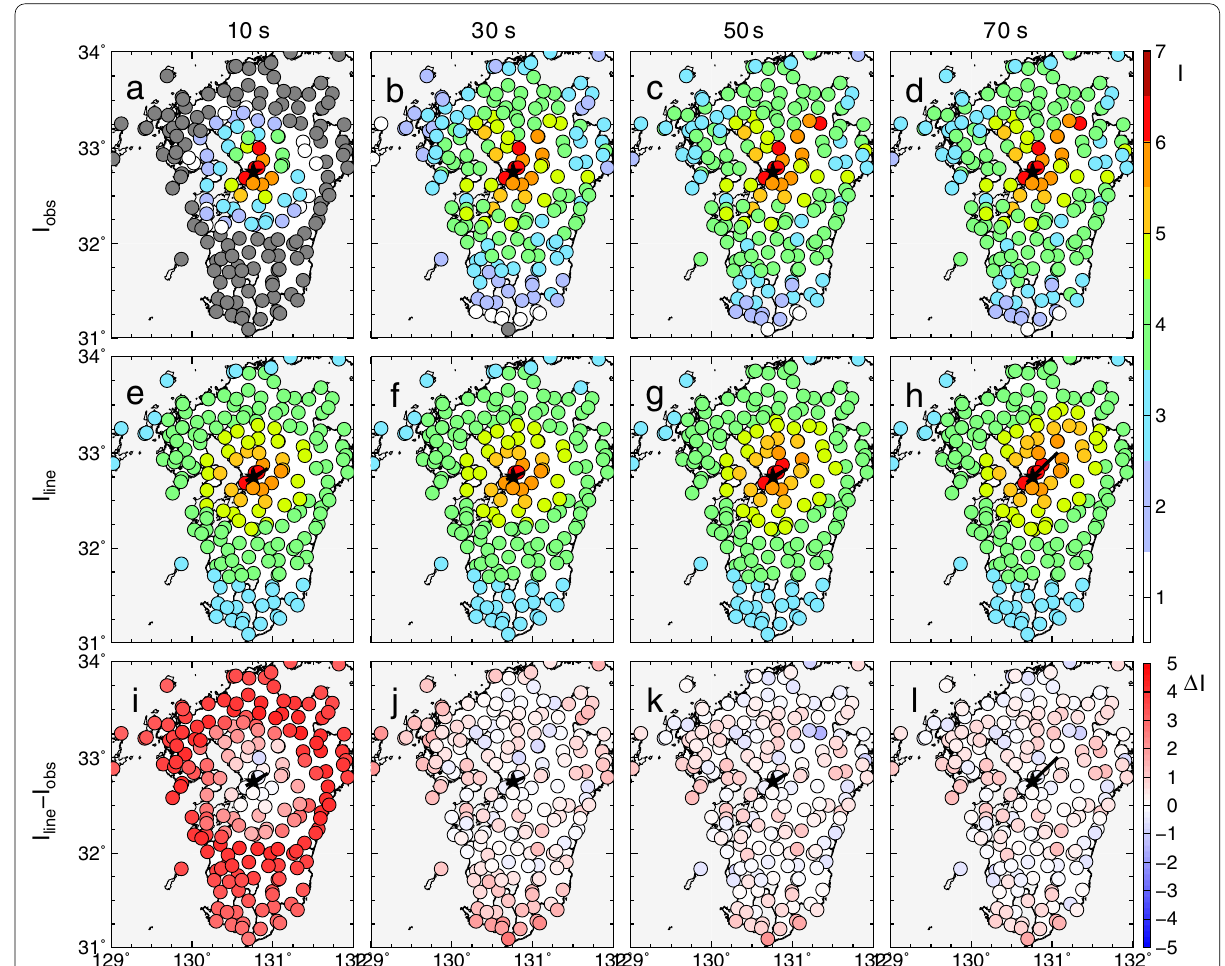
Fig. 15 Distribution of observed intensity, estimated intensity, and the difference between them at 10 s, 30 s, 50 s, and 70 s with the line-source model for the 2016 Kumamoto earthquake. The format is the same as Fig.